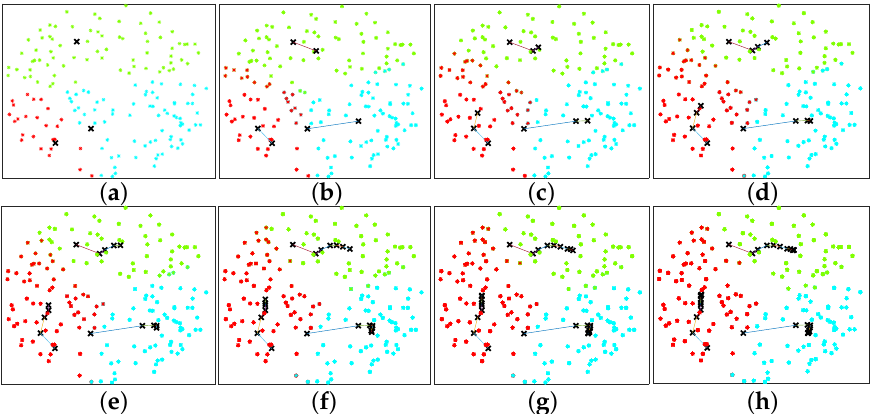
Figure 3. Illustration of ABS placement and UE association obtained using the approach in [14], where R B = 2000 m, α N = 2.5, α L = 2, λ U = 2 × 10 − 4 /m 2 , δ = 0, N UAV = 3, H ∗ = 300 m, N T = 70. The position of the ABS is represented using X . The three colors differentiate the UE clusters at a particular stage. ( a – h ) illustrate the 1st,. . .,5th, 7th, 9th and 11th adaptive stages,